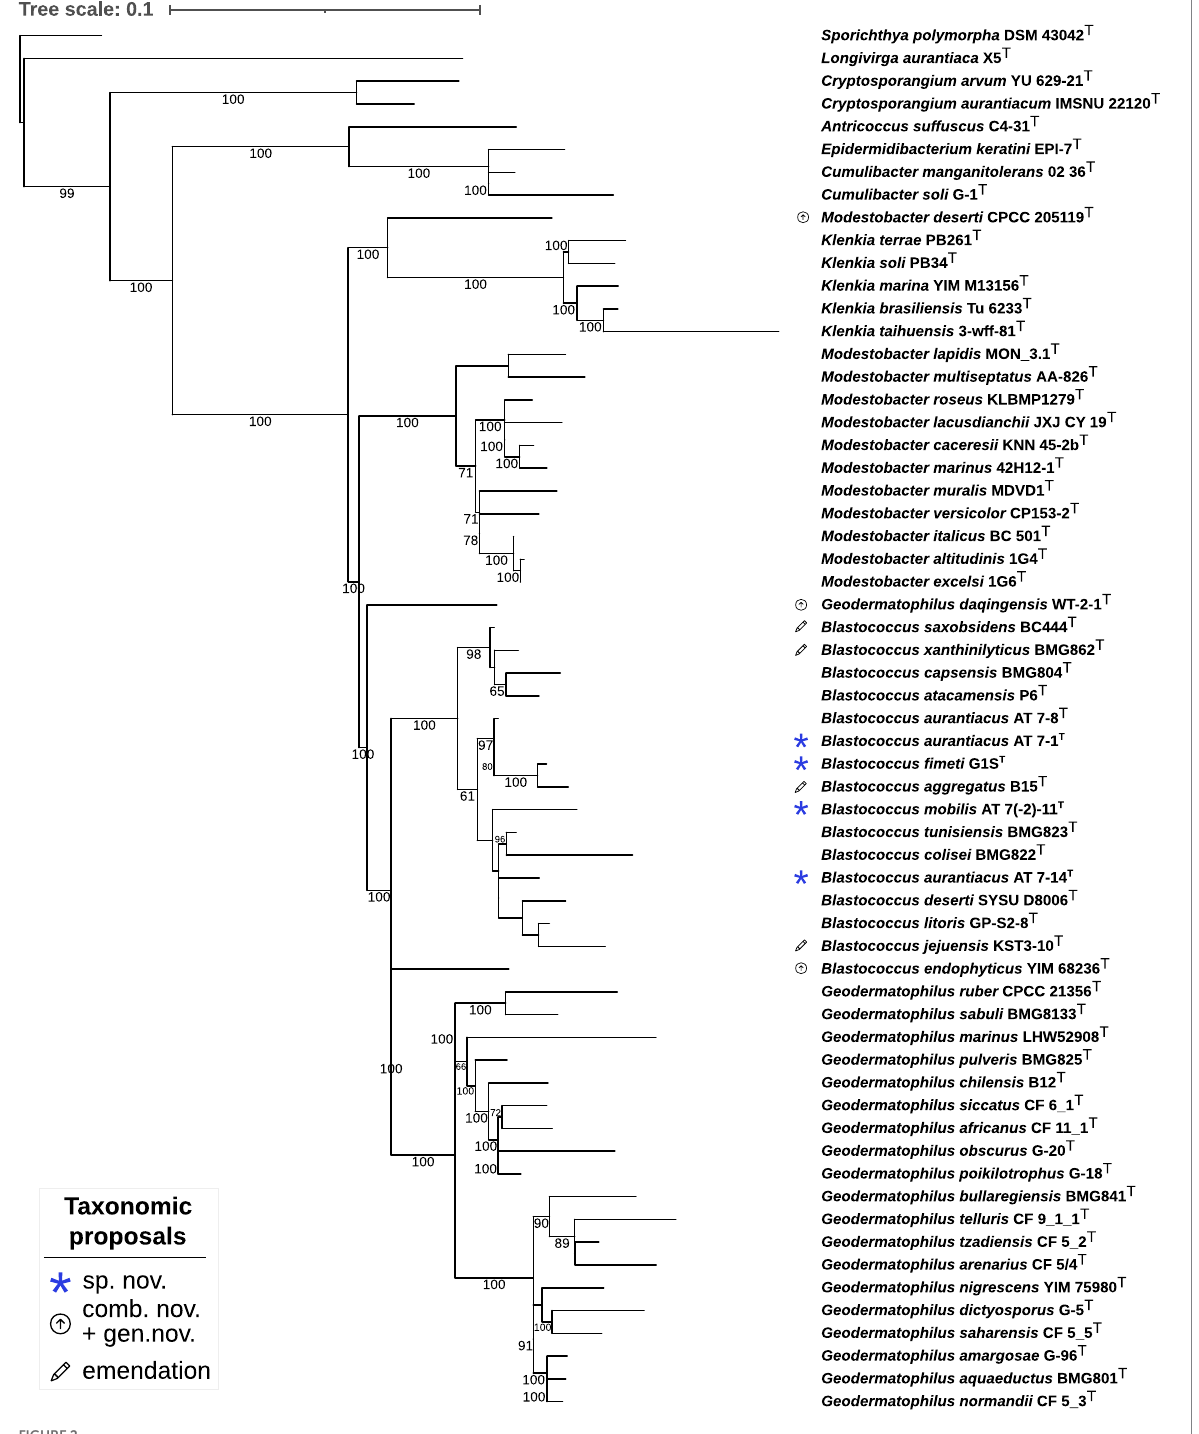
FIGURE 2 Maximum likelihood phylogenetic tree inferred from 16S rRNA gene sequences, showing the phylogenetic position of the strains DSM 44205 T , DSM 44268 T , DSM 44269, DSM 44270 T and DSM 44272 T relative to the type strains within Geodermatophilaceae . The branches are scaled in terms of the expected number of substitutions per site (see size bar). Support values from maximum-likelihood constrained bootstrapping are shown above the branches if equal to or larger than